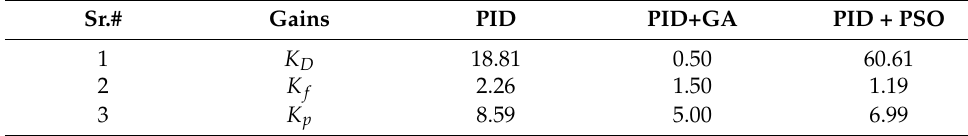
Table 3. Different parameters used for PID controllers.